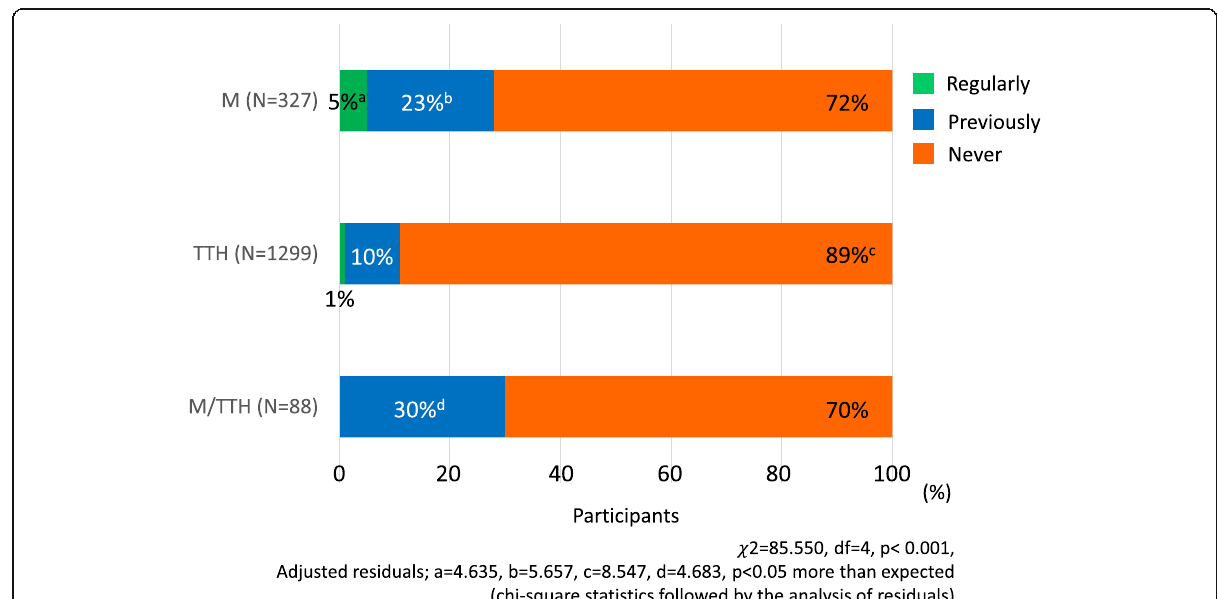
Fig. 2 Consultation to the medical institutions. M, migraine group; TTH, tension-type headache group; M/TTH, a group that satisfies the diagnostic criteria for migraine and tension-type